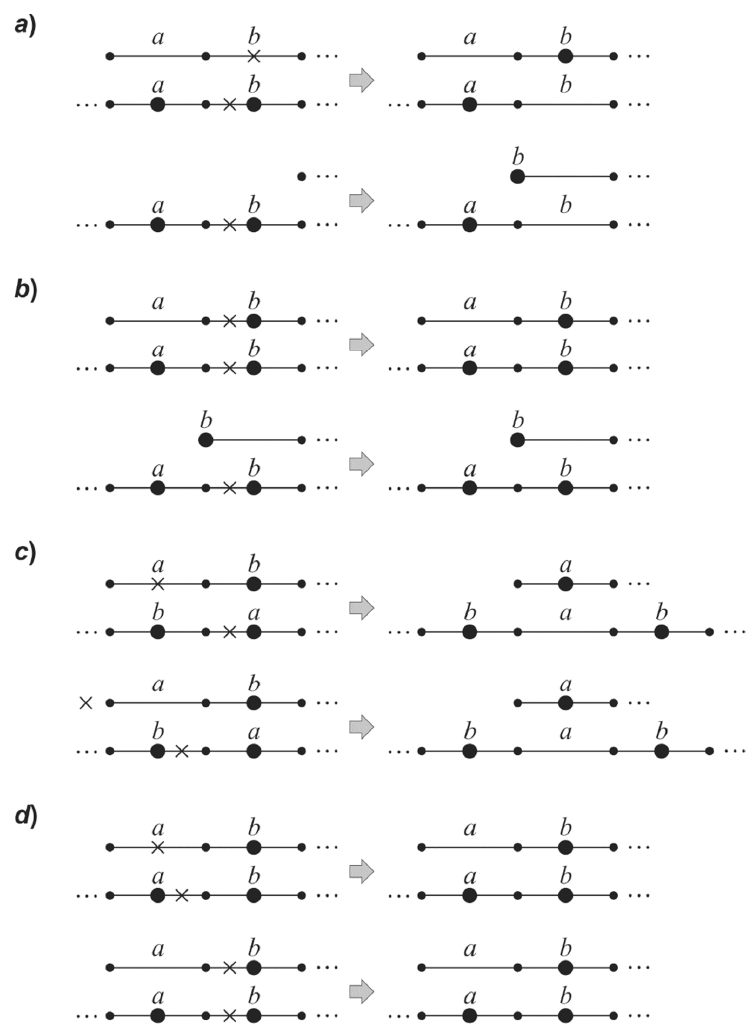
Figure 5. DM with an exterior cut at a conventional edge. ( a ) Reduction to an SM for an exterior cut at the next to extremal conventional edge. Top: initial DM. Bottom: SM obtained from the initial DM by removing two conventional edges. ( b ) Reduction to an SM for an exterior cut at the next to extremal singular edge. ( c ) Reduction to an SM for an exterior cut at an extremal conventional edge. The fictitious cut outside the end of the chain corresponds to replacement of the DM with an SM. ( d ) Reduction of a cut at an extremal conventional edge to the case considered in Figure 5b.